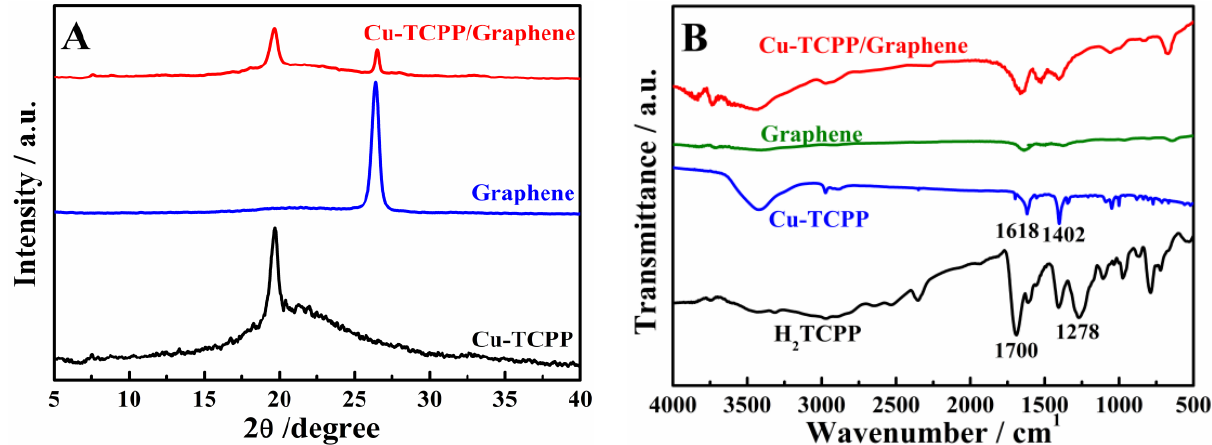
Figure 1. XRD pattern ( A ) and FT-IR spectra ( B ) of the prepared materials.